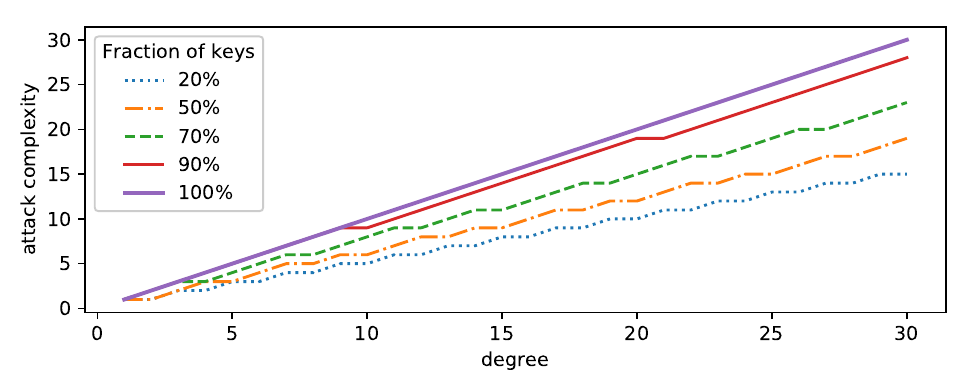
Figure 1: The complexity of the attack, measured as a power of p , as a function of the degree of f and the desired fraction of keys we want to